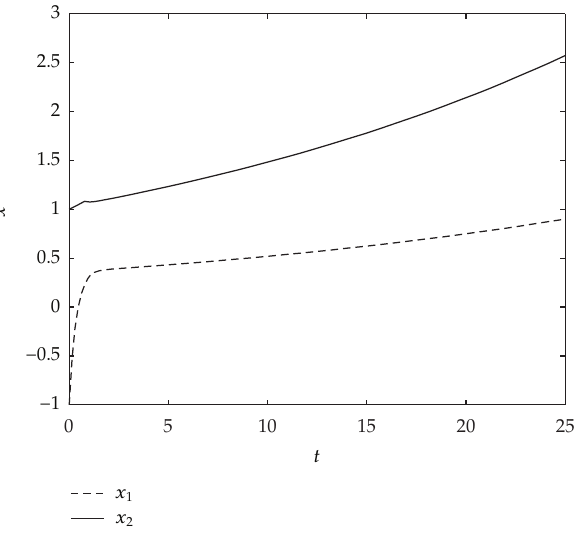
Figure 2: The trajectory of solution of system i (cid:8) 2. Table 2: Maximum allowable upper bounds h 2 of the time-varying delay for di ff erent values of the lower bounds h 1 in example 2 of (cid:4) 4 (cid:5)